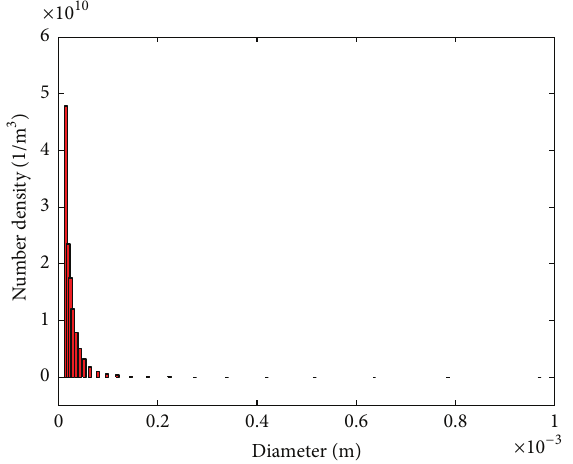
Figure 19: Plot of the number density of bubble in a plane near to the gas inlet for nozzle 3.